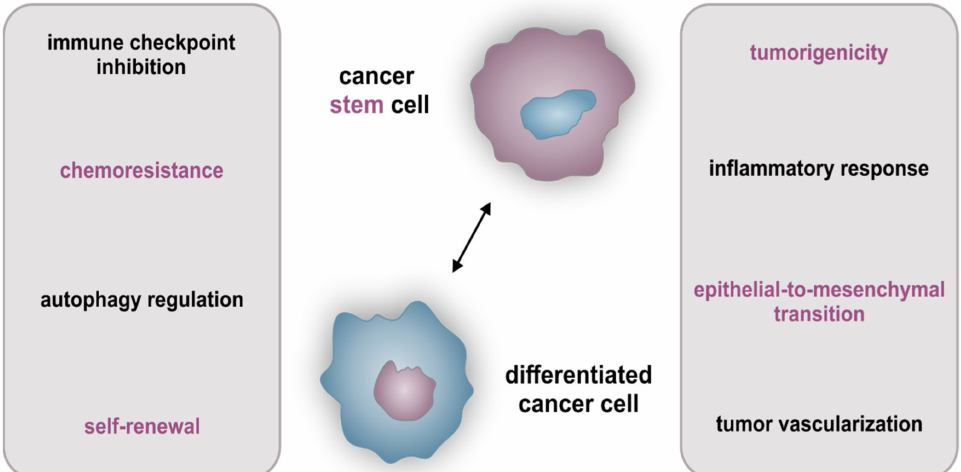
Figure 1. CSC- as well as incorporated cancer cell characteristics. Features and benefits for sur- vival/maintenance of CSCs and (partially) differentiated cancer cells, whereas magenta characteristics exclusively describe cells possessing the stemness